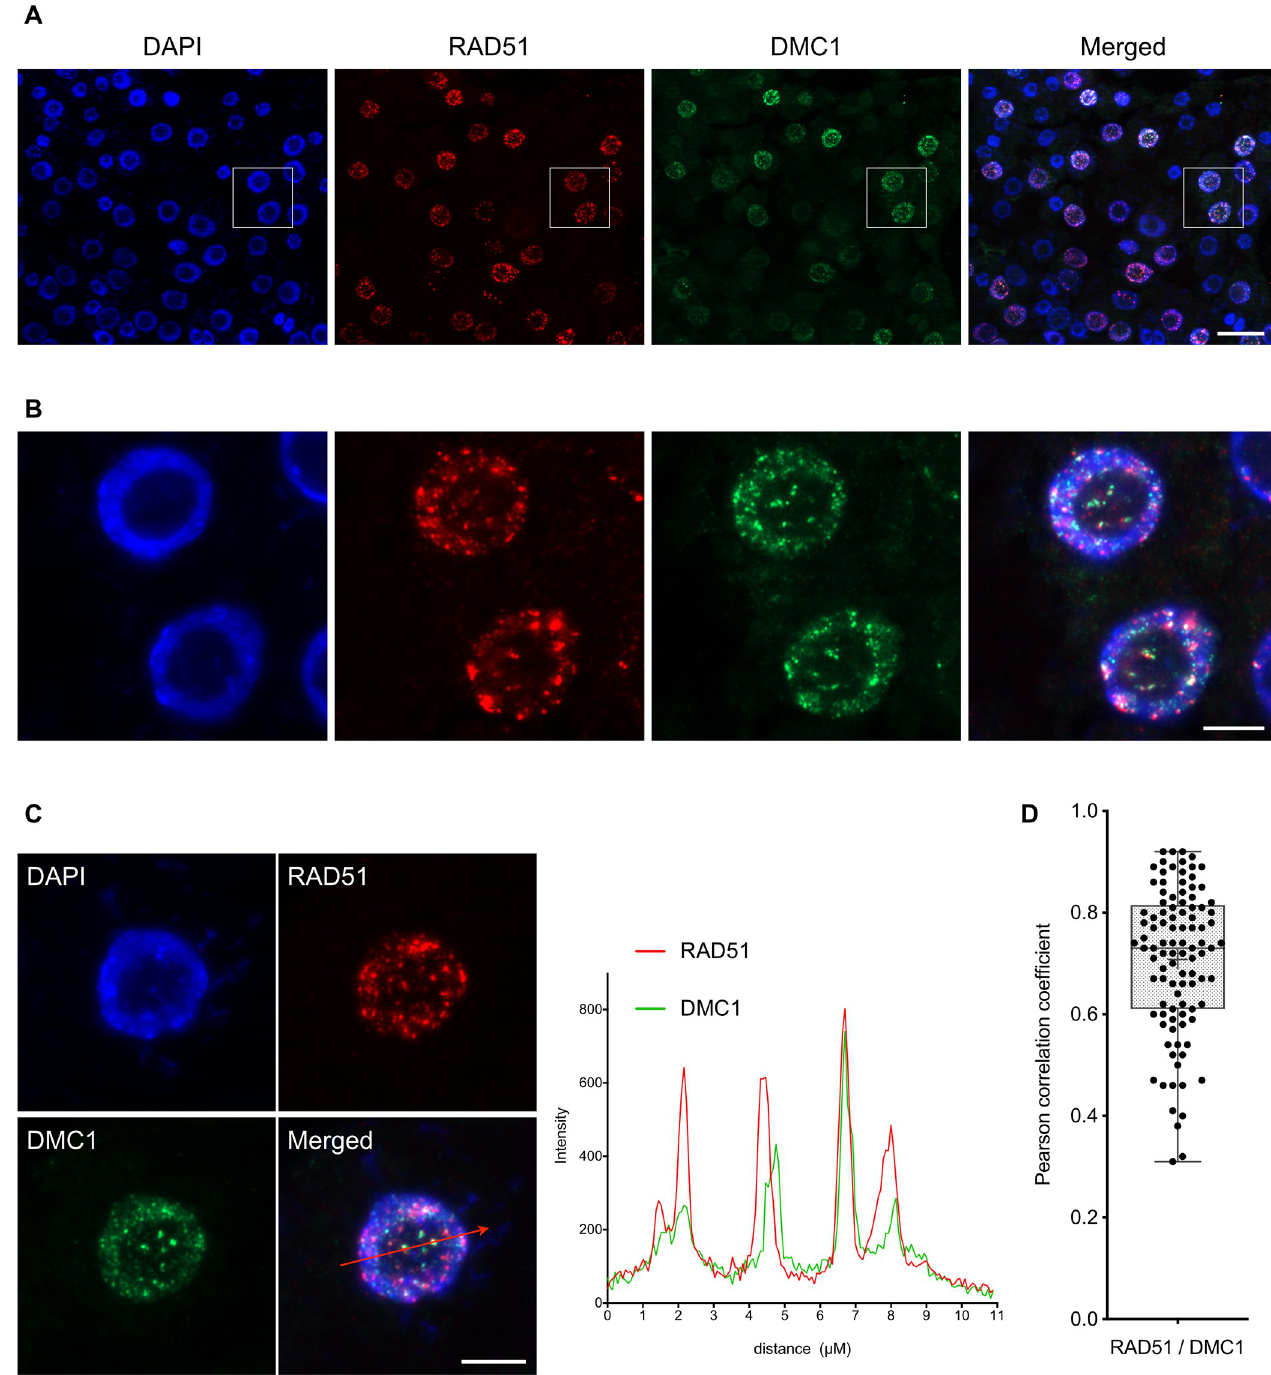
Fig 5. DMC1 foci are formed in somatic cells upon DNA damage. (A-B) Immunolocalization of RAD51 and DMC1 in root tip nuclei of wild-type plants expressing pRAD51 :: DMC1g fixed 8 hours after treatment with 30 μ M Mitomycin C. (B) is a magnification of the area framed in (A) . DNA is stained with DAPI (blue), RAD51 foci are colored in red and DMC1 in green. Images are collapsed Z-stack projections of a deconvoluted 3D image stack. (Scale bars: 20 μ m (A) and 5 μ m (B) ). (C) Example of RAD51 and DMC1 signal intensity distribution of the total amount of pixels through a section of the depicted stained nucleus (red line). RAD51 is shown in red and DMC1 in green. (Scale bar: 5 μ m). (D) Range of Pearson correlation coefficients (PCCs) of RAD51/ DMC1-positive foci formed after 8 h of MMC treatment. RAD51/DMC1 partially co-localized in foci with a mean value of PCCs = 0.71 (n =